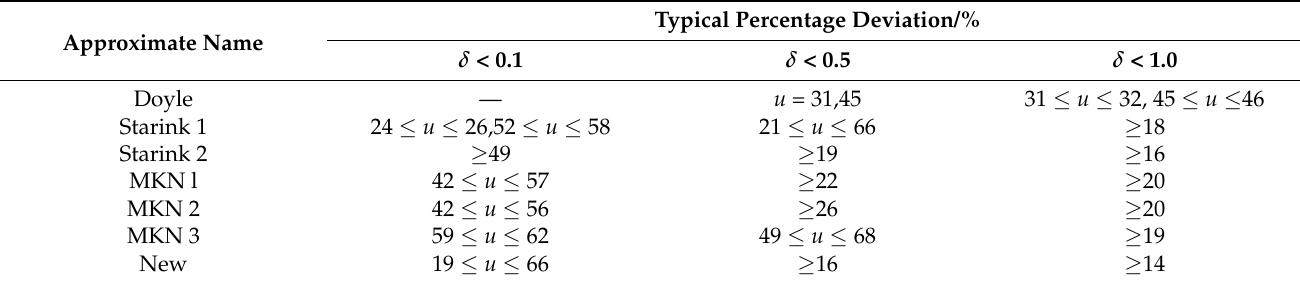
Table 3. The value range of u for different temperature integral equation at typical percentage